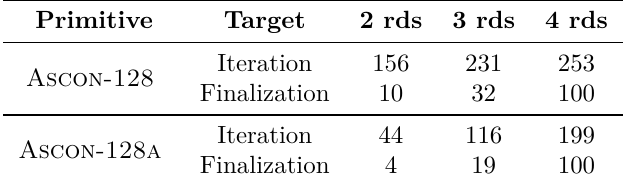
Table 7: Probabilities (in − log ) of the best characteristics found with additional 2 restrictions on the capacity part of Ascon-128 and Ascon-128a